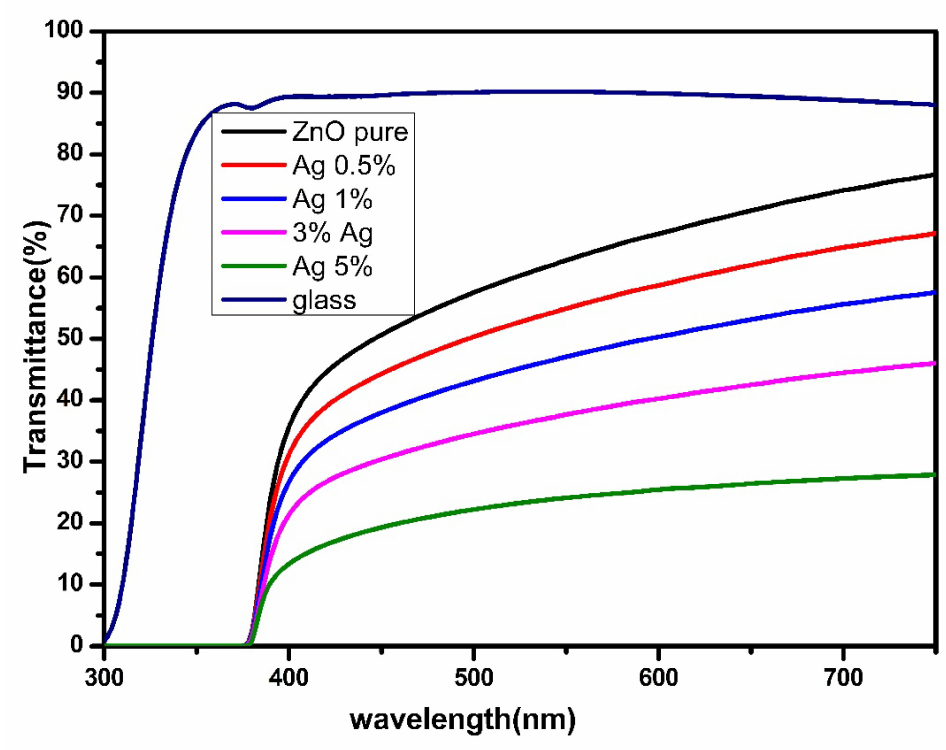
Figure 6. Optical transmittance for undoped ZnO and Ag-doped ZnO thin